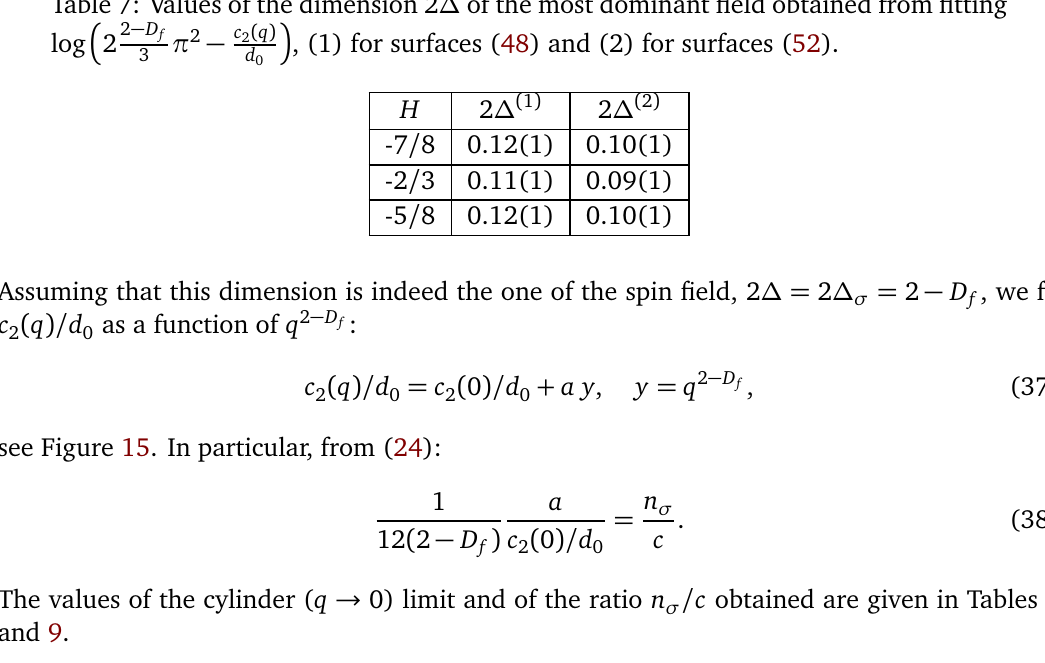
Table 7: Values of the dimension 2 ∆ of the most dominant field obtained from fitting